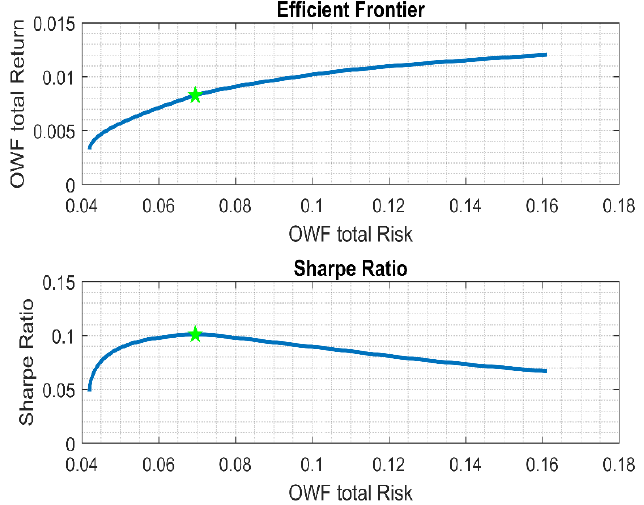
Figure 14. Sharpe ratio over different portfolios on efficient frontier.